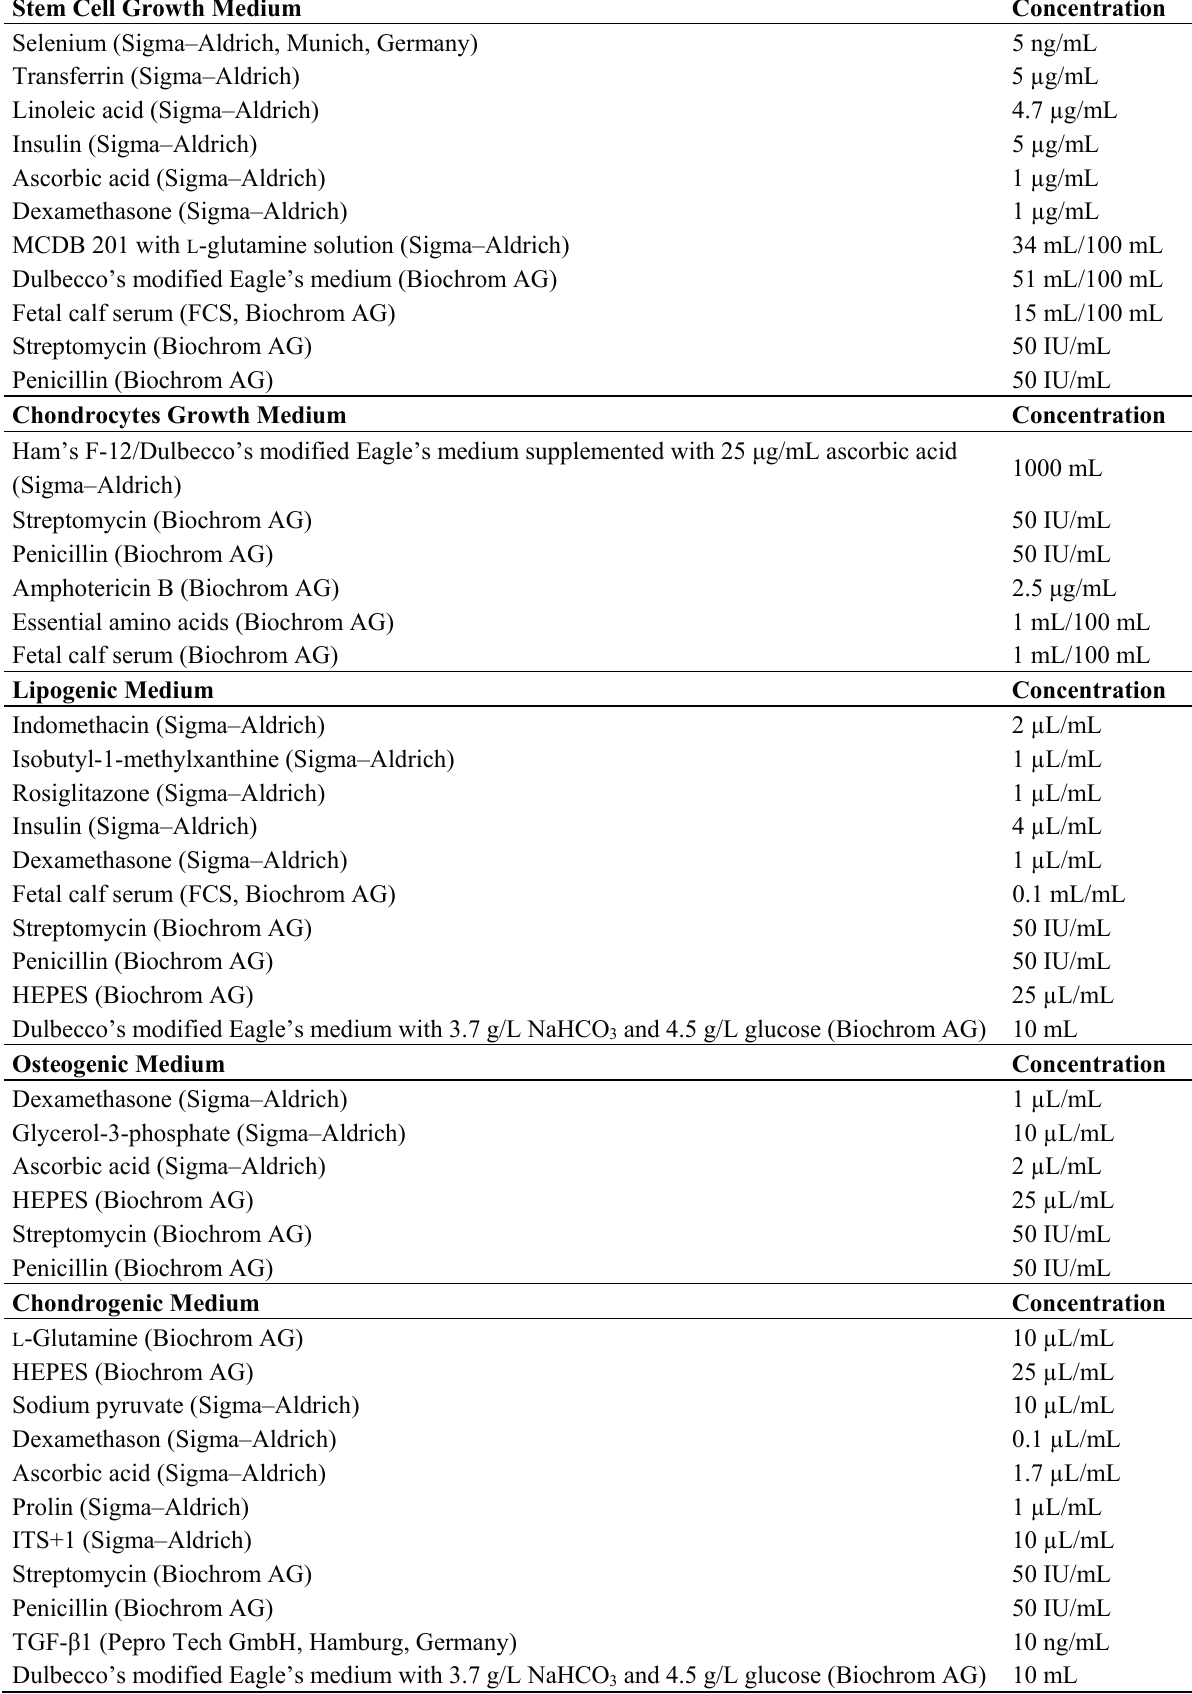
Table 1. Chemical composition of used growth